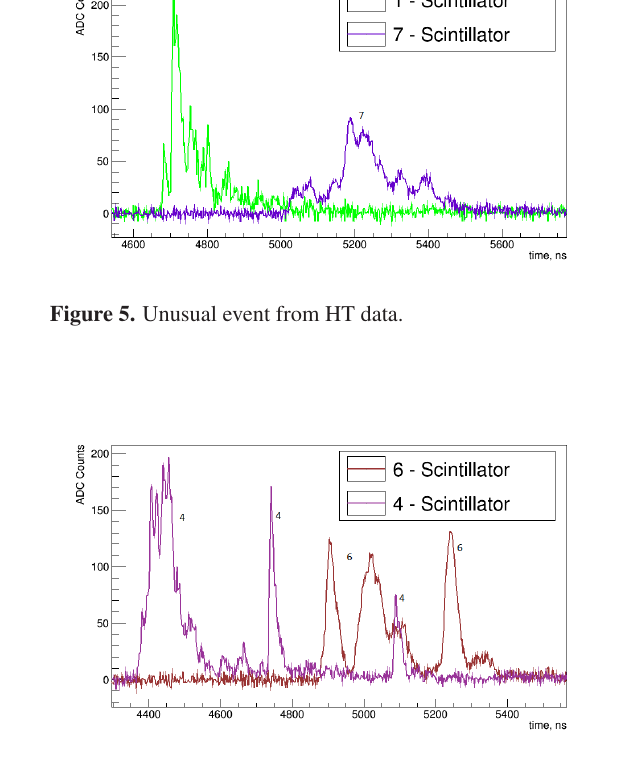
Figure 6. Unusual event from HT